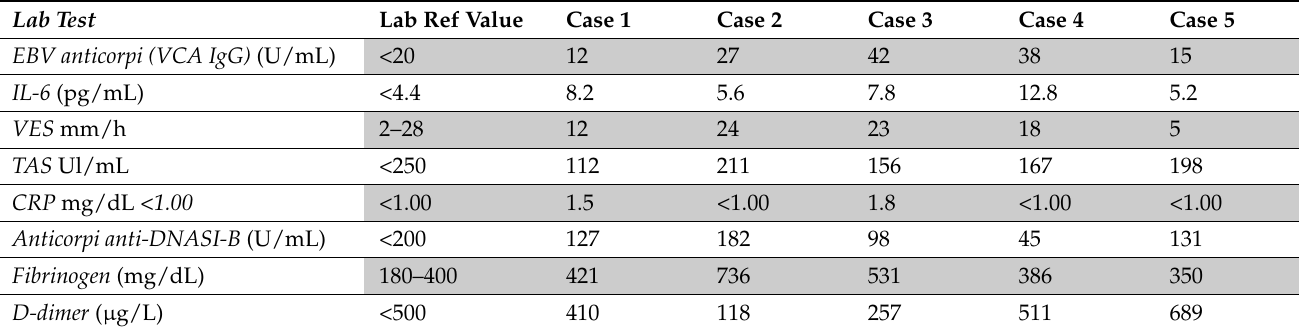
Table 3. Lab test results of the five